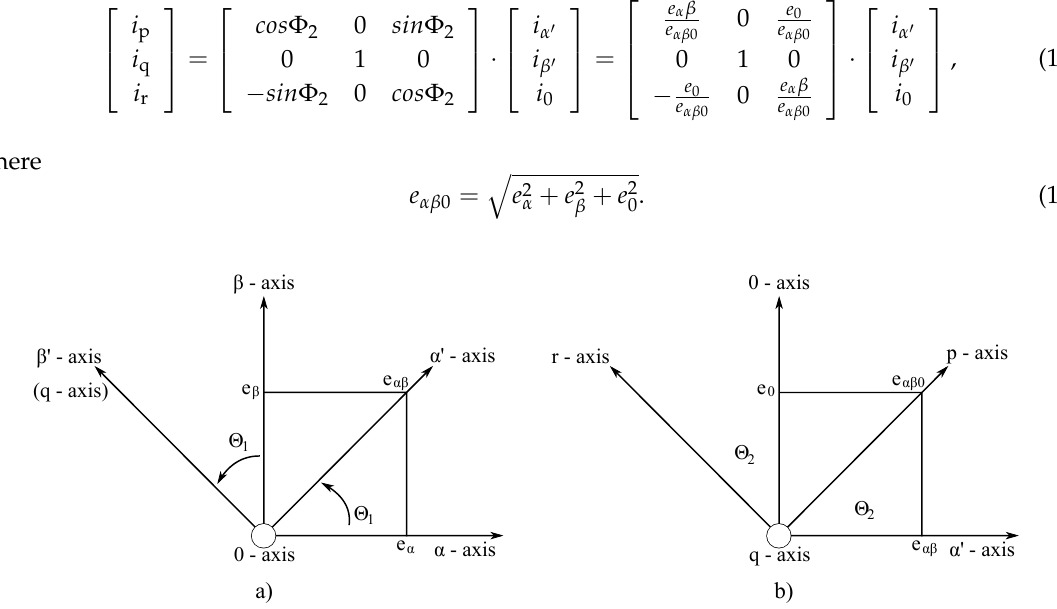
Figure 4. The physical importance of the coordinates p-q-r; ( a ) the relation between coordinates α (cid:48) - β (cid:48) -0 and α - β -0 (a view from the top of axis 0); and ( b ) the relation between coordinates α (cid:48) - β (cid:48) -0 and p-q-r (a bottom view of axis